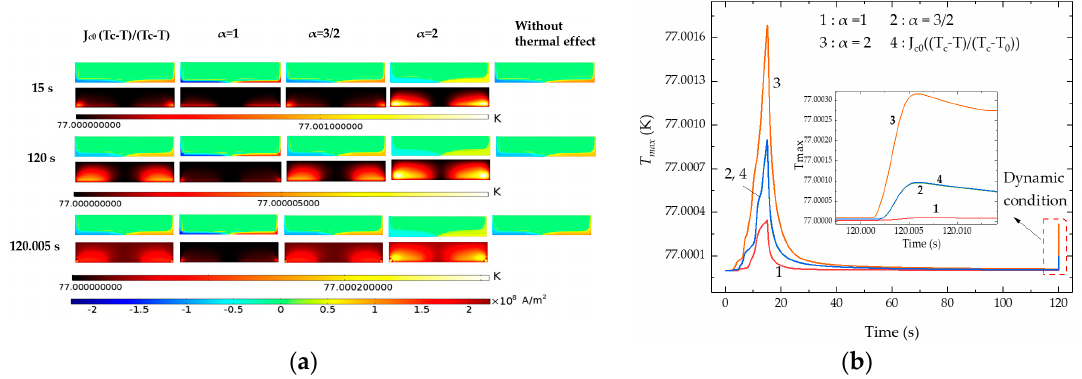
Figure 4. Comparison of different J c –T relationships of J c = J c1 (1-(T/T c ) 2 ) α with α = 1, 3/2, 2 and J c = J c0 ((T c -T)/(T c -T 0 )) under 60 Hz. ( a ) Current density and temperature profile inside the HTS bulk at 15 s, 120 s, and 120.005 s; ( b ) maximum temperature T max inside the HTS bulk versus time.